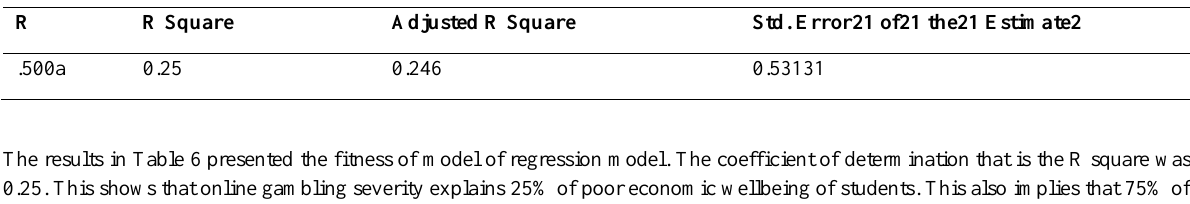
Table 6: Model Summary of Gambling Severity and Economic wellbeing